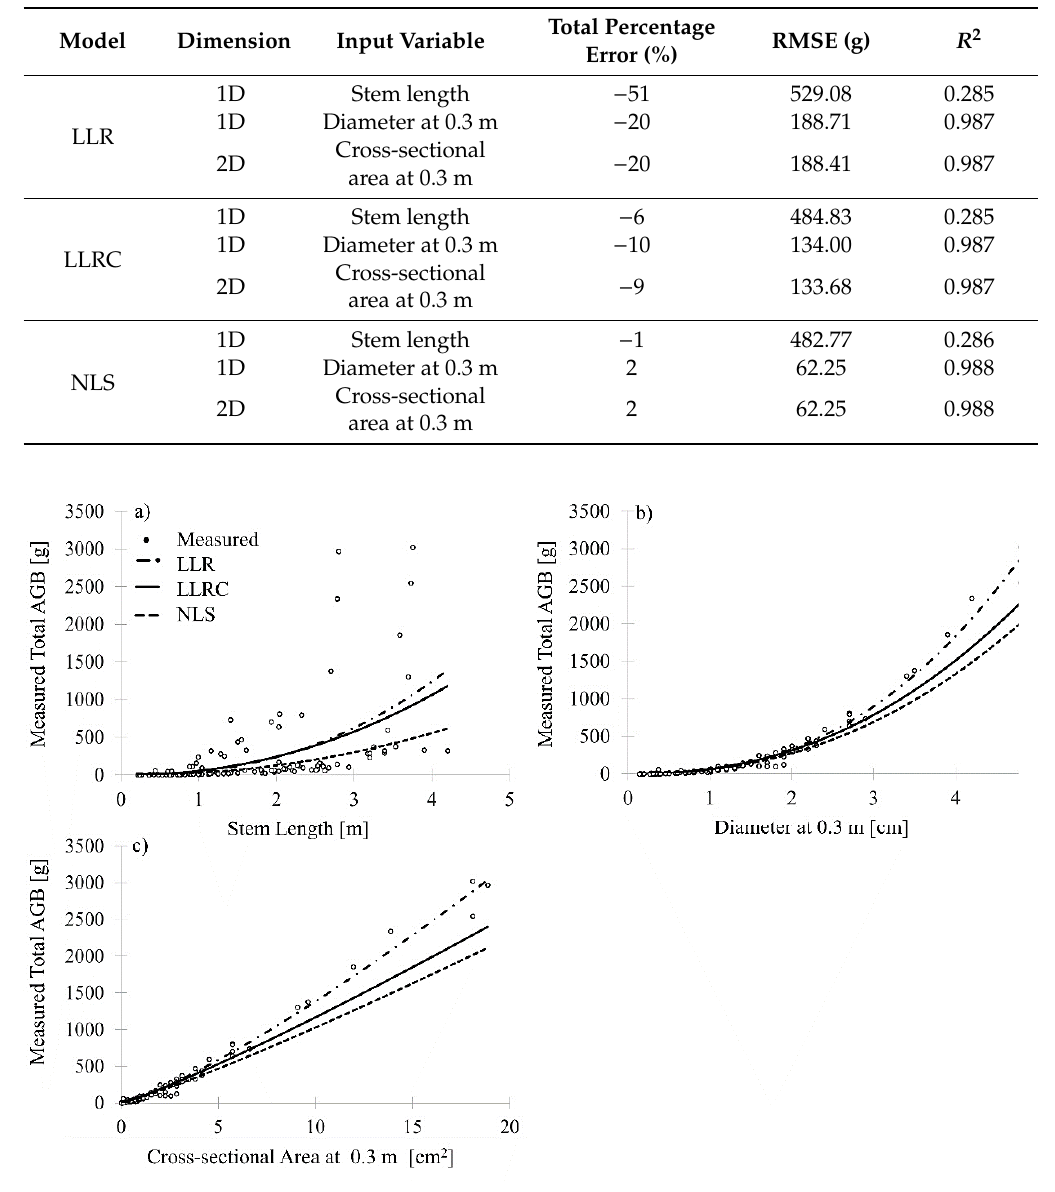
Figure 4. LLRC, LLR, and NLS model fits for each 1D ( a , b ), and 2D ( c ) predictor variable utilized to model total AGB for multispecies trees. Table 5. Regression coe ffi cients to predict total AGB for multispecies trees with LLRC and